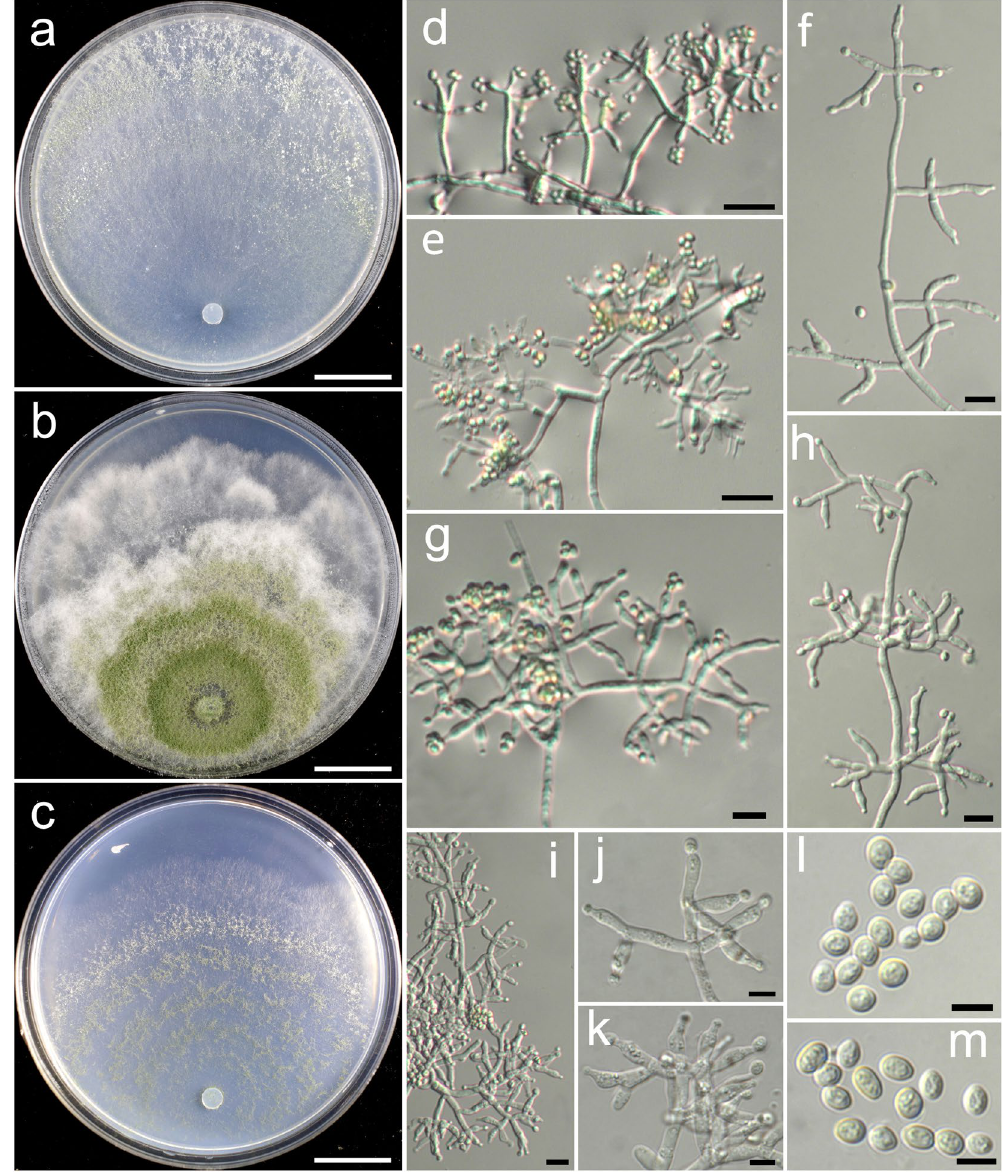
Figure 16. Trichoderma liberatum (HMAS 248831). ( a – c ) Cultures at 25 °C, 7 d (a. on CMD; b. on PDA; c. on SNA); ( d – k ) Conidiophores and phialides (PDA, 5 d); ( l , m ) Conidia (PDA, 5 d). Bars: a–c = 20